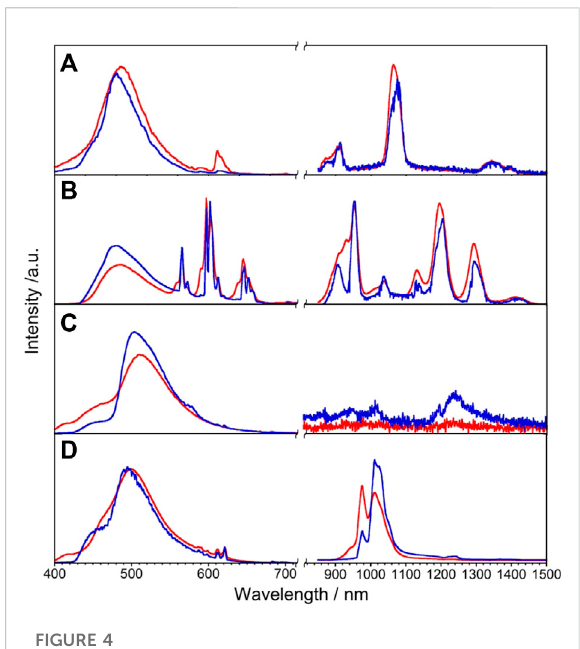
FIGURE 4 Luminescence spectra ofLn L ,Ln = Nd (A) ,Sm (B) , Dy (C) ,and Yb (D) , in the solid state at rt (red) and 77 K (blue), λ ex = 380